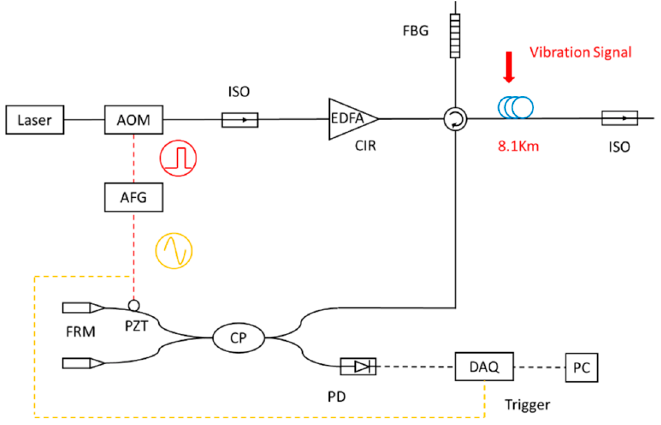
Figure 1. Setup of the Φ -OTDR system.